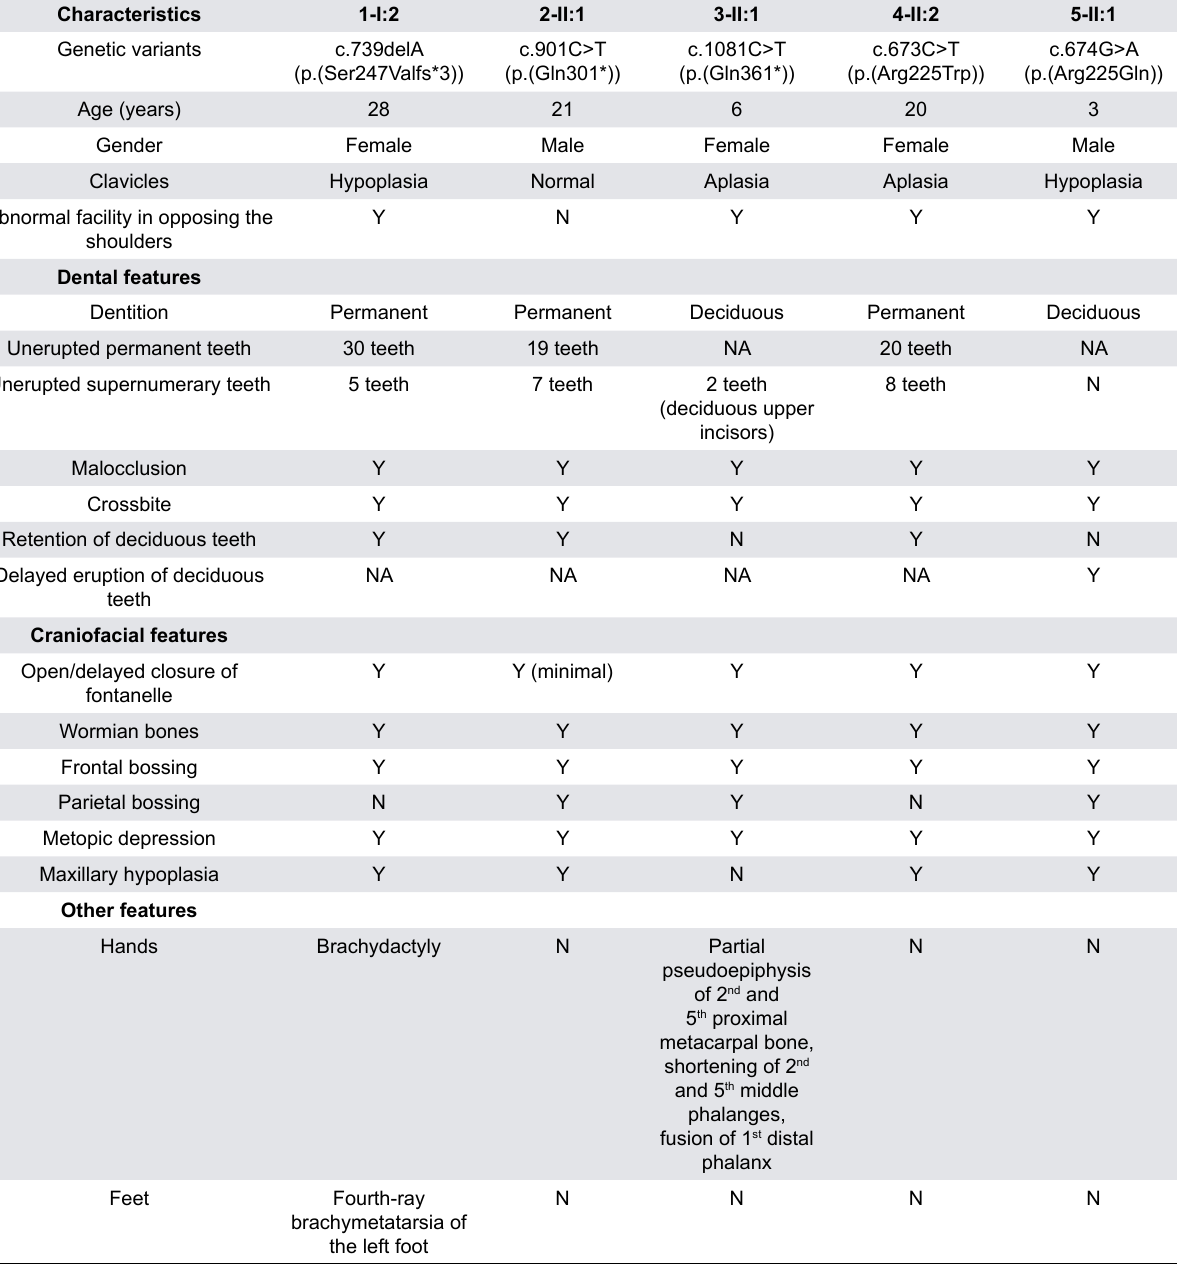
Table 1- Phenotypes of the CCD patients with different RUNX2